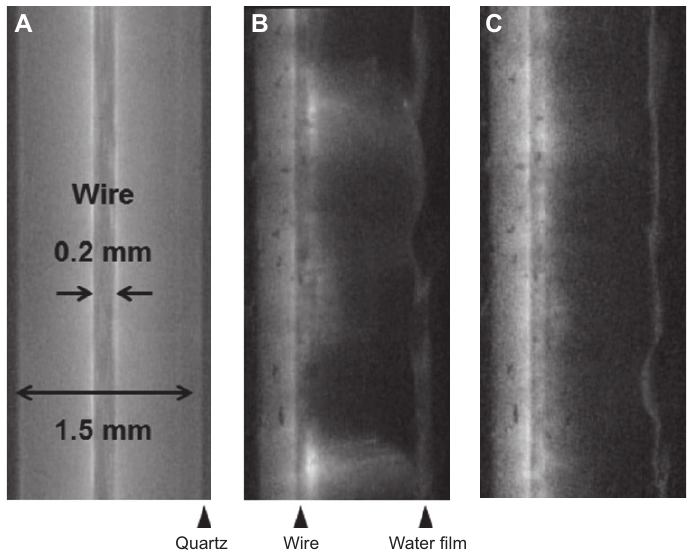
= O = 20 cm 3 /min: 4 2